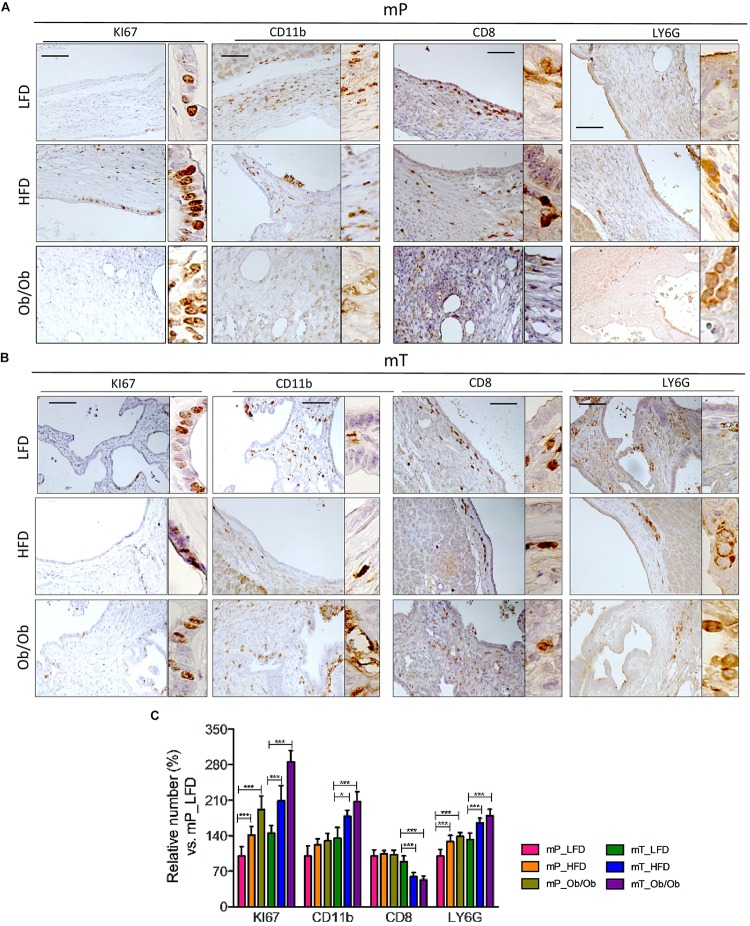
Obesity affected the immune infiltrate in organoid –transplant systems. Representative immunohistochemical staining for Ki67, CD11b, CD8, and LY6G positive cells in tissues from mice bearing (A) mP and (B) mT organoid-derived cells. Scale bars, 100 μm. The experiment was performed in three model of each group. (C) Quantification of paraffin-embedded tumor sections stained immunohistochemically with antibodies against Ki67, CD11b, CD8, and LY6G. Number of positive cells were from ten different area with pancreatic lesions. The mean values and standard deviation are shown. ***, p < 0.001; *, p < 0.05 by two-tailed unpaired Student’s t-tests.